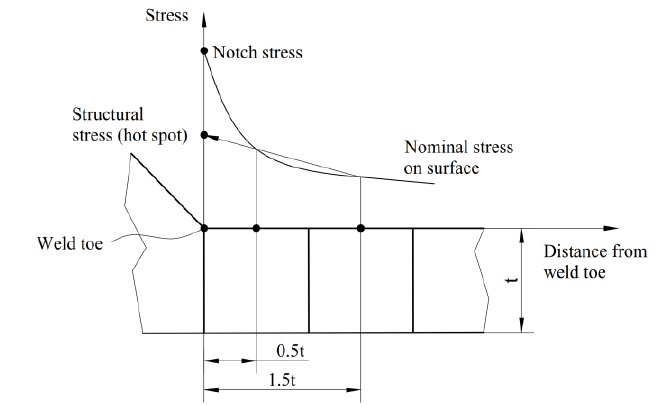
Figure 9. Hot-spot stress extrapolation.